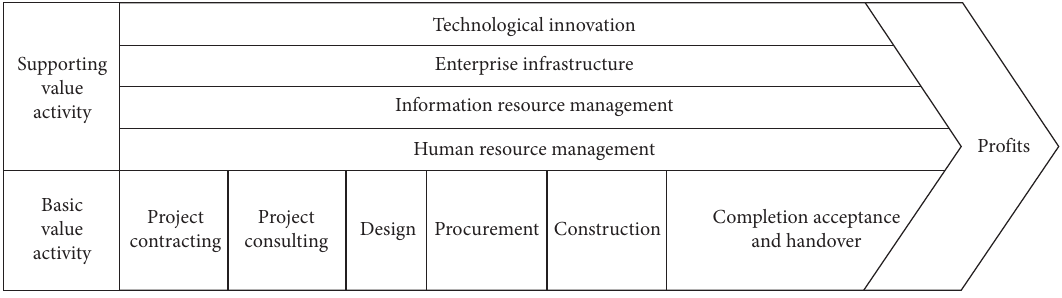
Figure 1: The value chain of the general